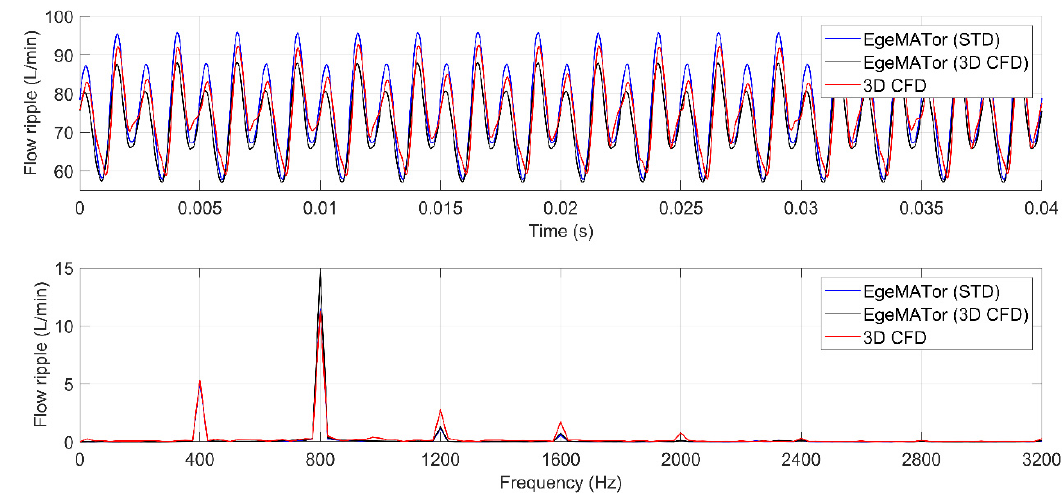
Figure 10. Outlet flow ripple at 1500 rev/min and 350 bar in time and frequency domains.